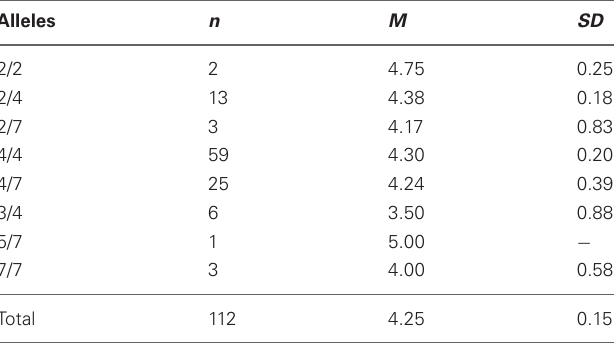
Table 2 | Descriptive statistics (means and standard deviations)